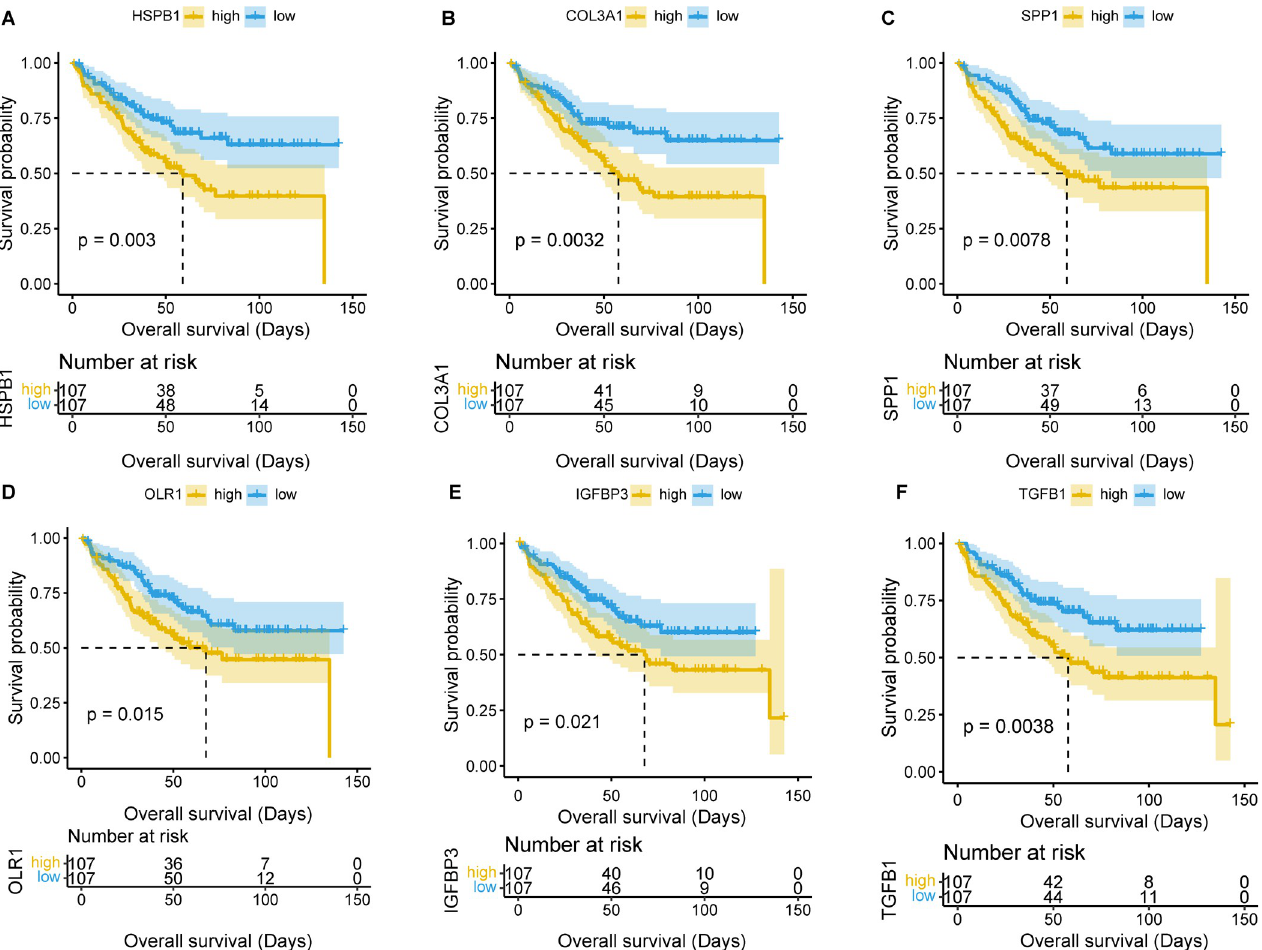
Fig 6. Survival analysis results for the 52 core target genes (performed in 214 CRC samples from